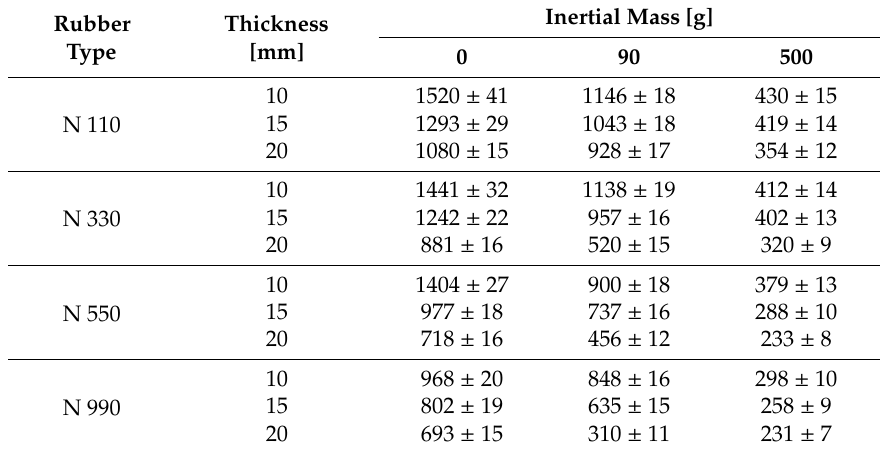
Table 4. The first resonance frequency (f R1 ) in Hz of the studied rubber composite materials, as induced by harmonic force vibration for di ff erent rubber thicknesses and inertial